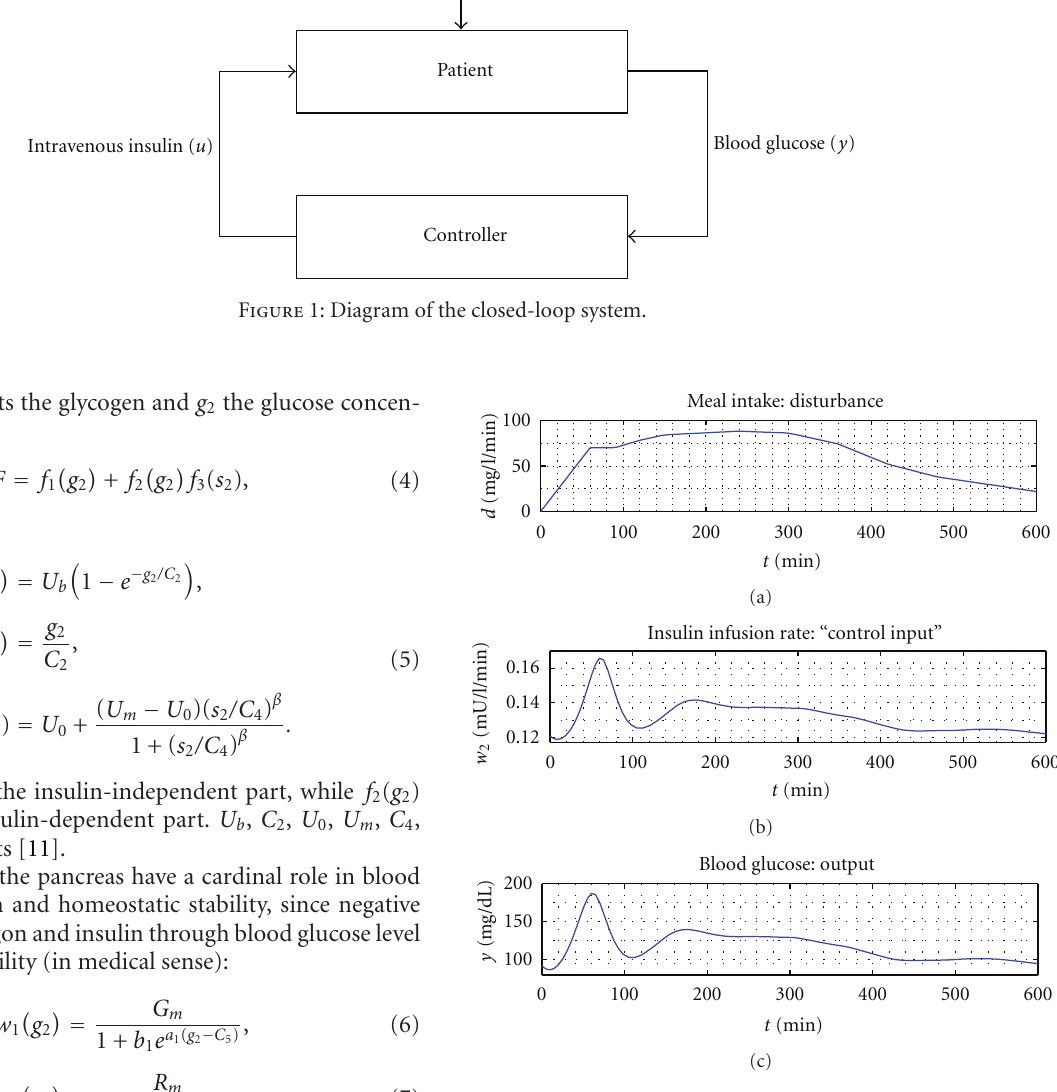
Figure 2: Open-loop simulation results of the original Liu-Tang